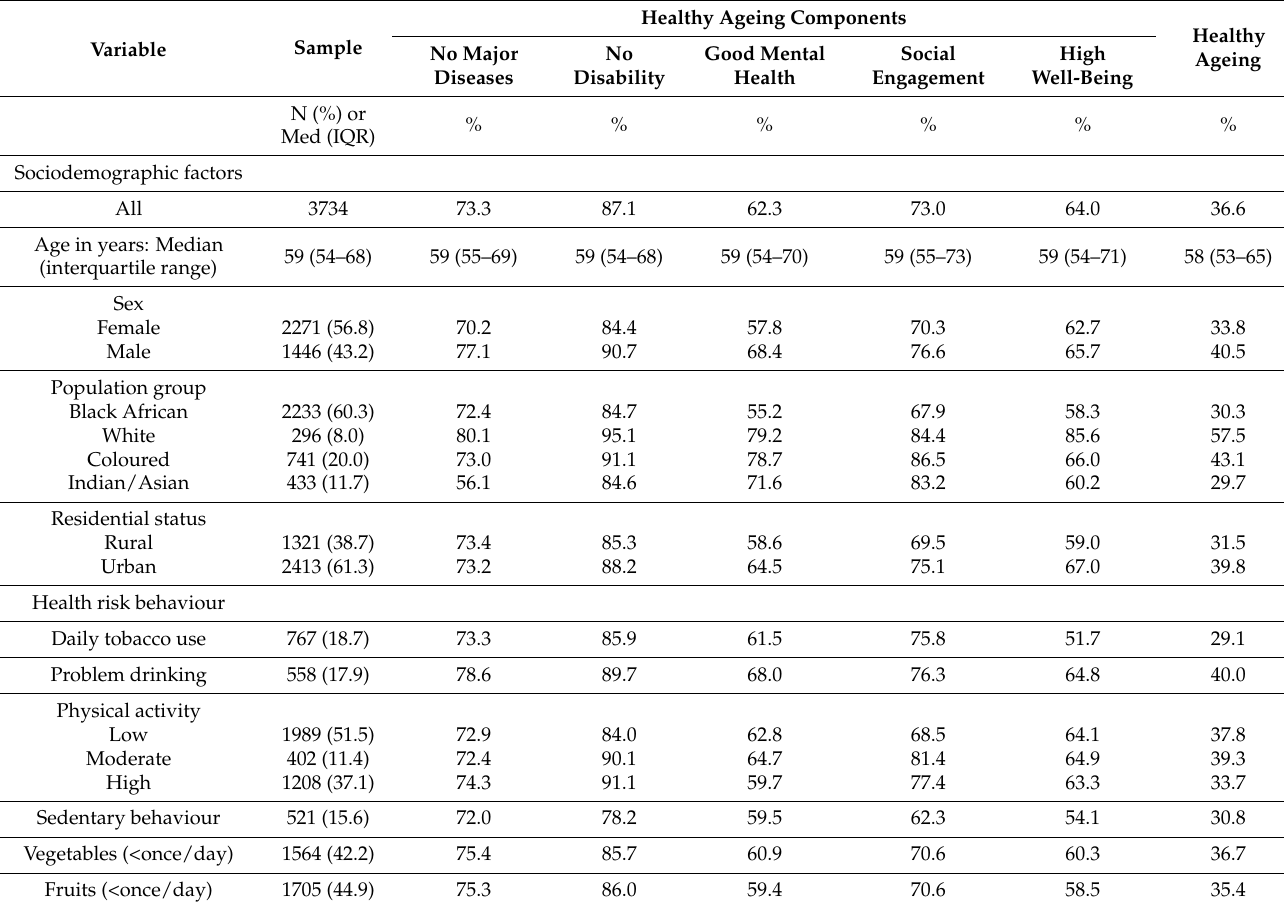
Table 1. Sample and healthy ageing characteristics among older adults ( ≥ 50 years) in South Africa,